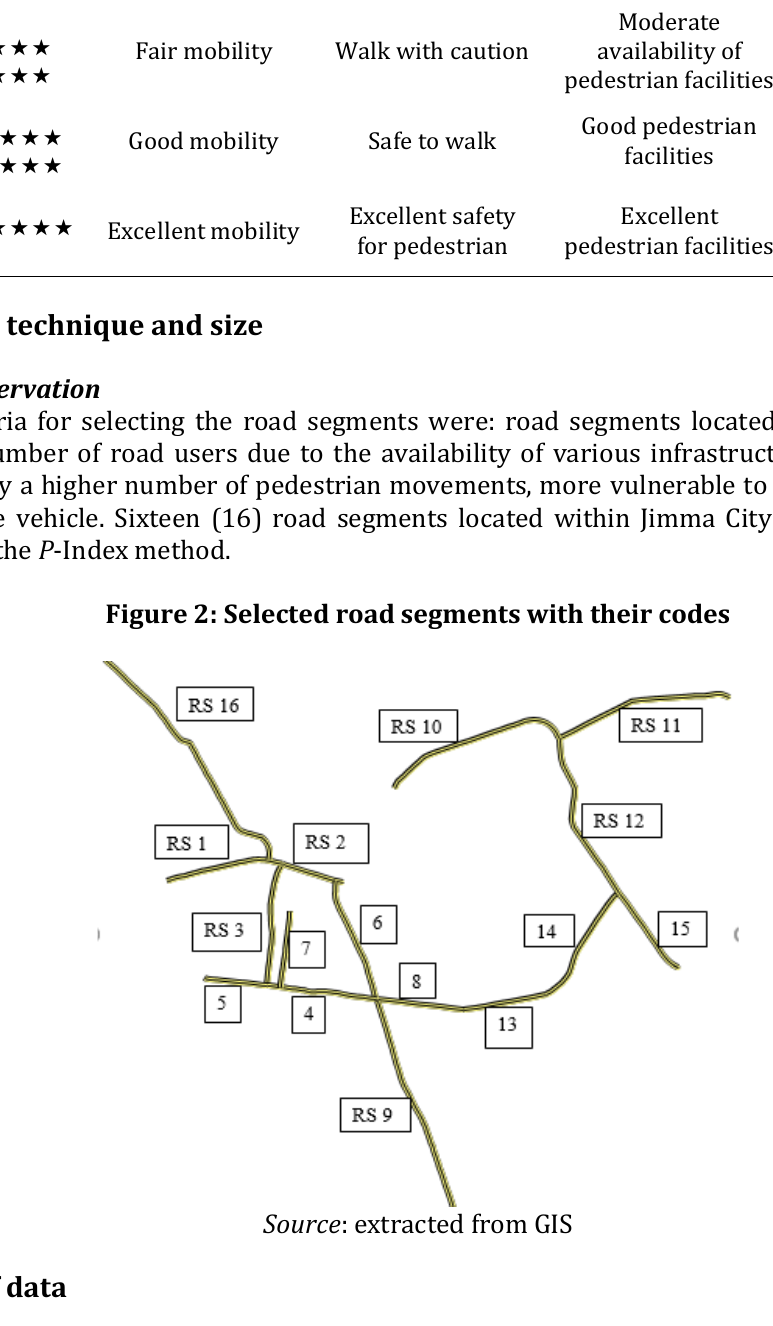
Source : extracted from